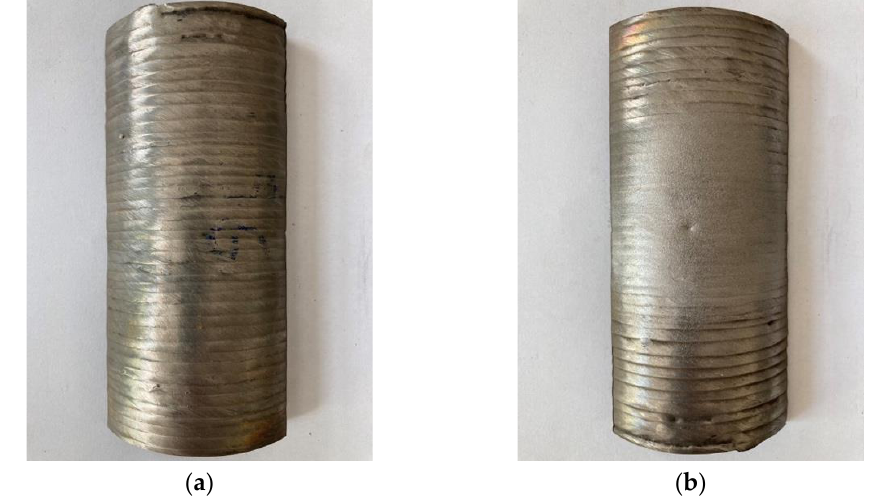
Figure 13. View of the test specimens on the example of Stellite 6 coatings before ( a ) and after ( b ) the abrasive blasting wear test.